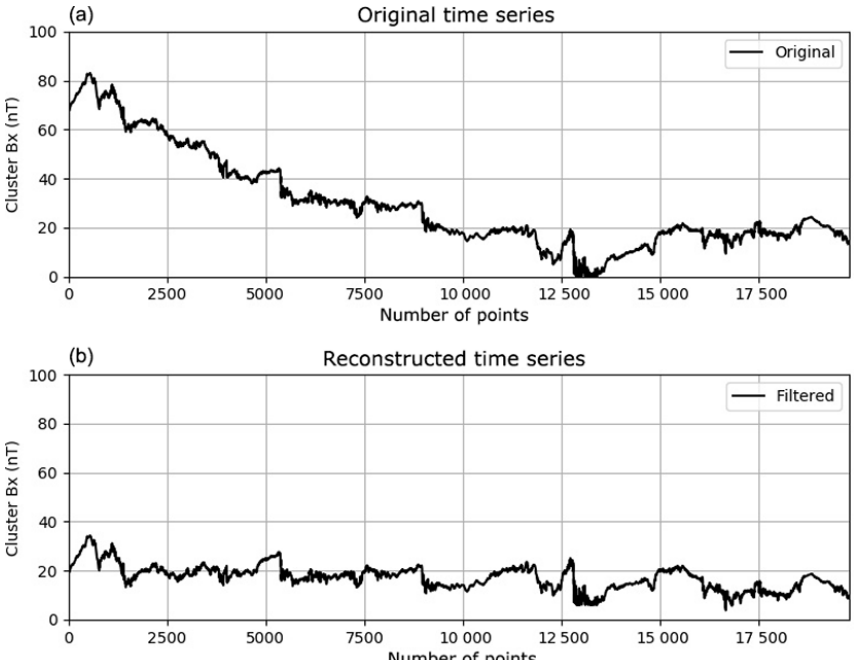
Figure 3. Geomagnetic field B x component data for the interval that the Cluster was in the magnetotail during the HILDCAA event, which occurred between 22:19UT on 5 August to 22:54UT on 7 August 2005. Panel (a) shows the original data and (b) shows the detrended data after removal of the long tendency. In (a) and (b) the x axes represents the number of